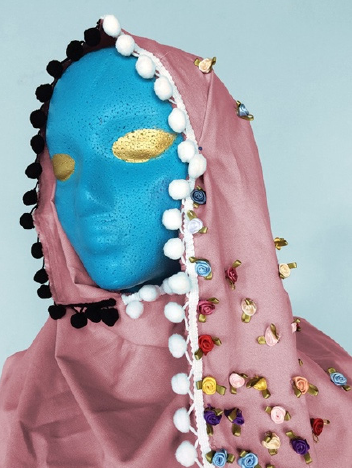
Figure 1. Tabarek’s piece at the Utah Museum of Contemporary Art.